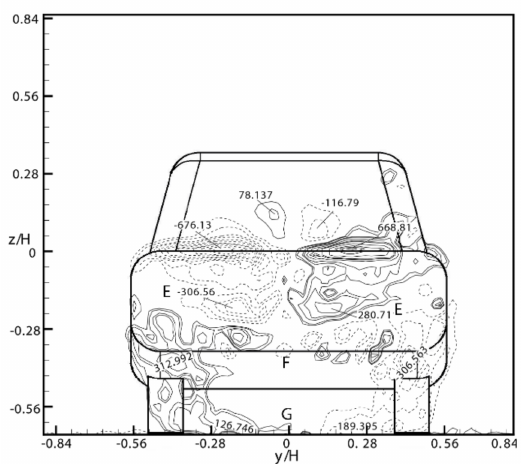
Figure 7. Iso-contours of time-averaged stream-wise vorticity, ω x in the y–z plane at x/H = 0.28. Min- imum and incremental values of vorticity are ω x,min = − 65.067 s − 1 , 56.812 s − 1 , and ∆ ω x = 91.841 s − 1 ,